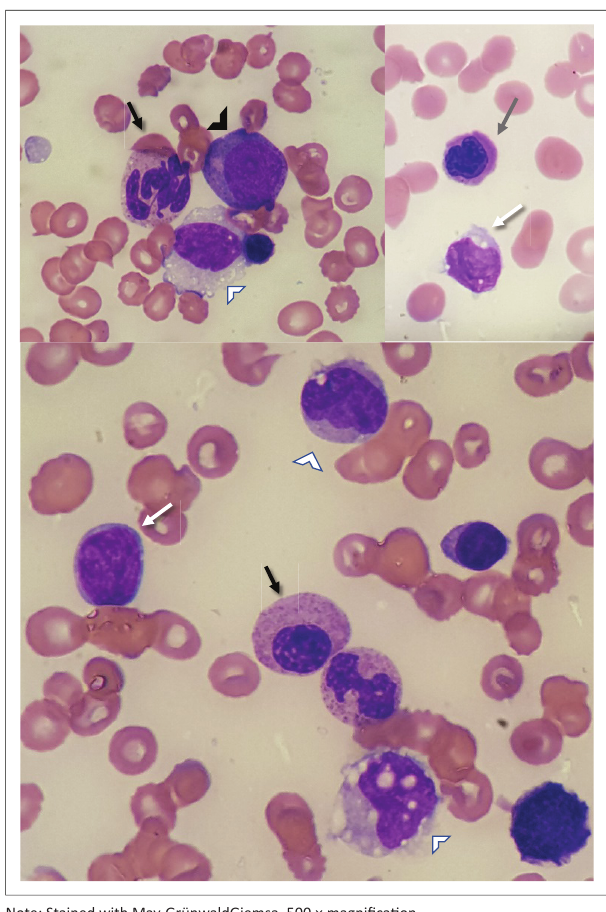
FIGURE 1: Images from the peripheral blood showing disordered neutrophils (black arrows), blasts (white arrows), a granulocyte precursor (black arrowhead), monocytes (white arrow heads) and a dysplastic